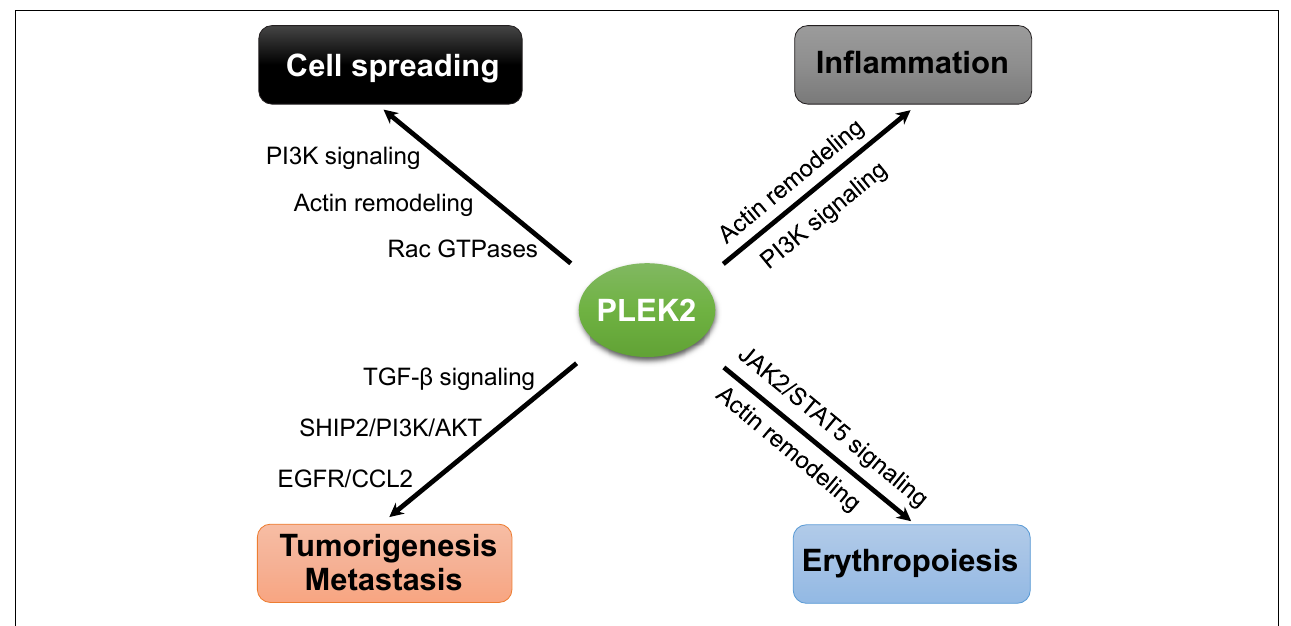
FIGURE 3 | Emerging roles of PLEK2 in the regulation of different biological events.